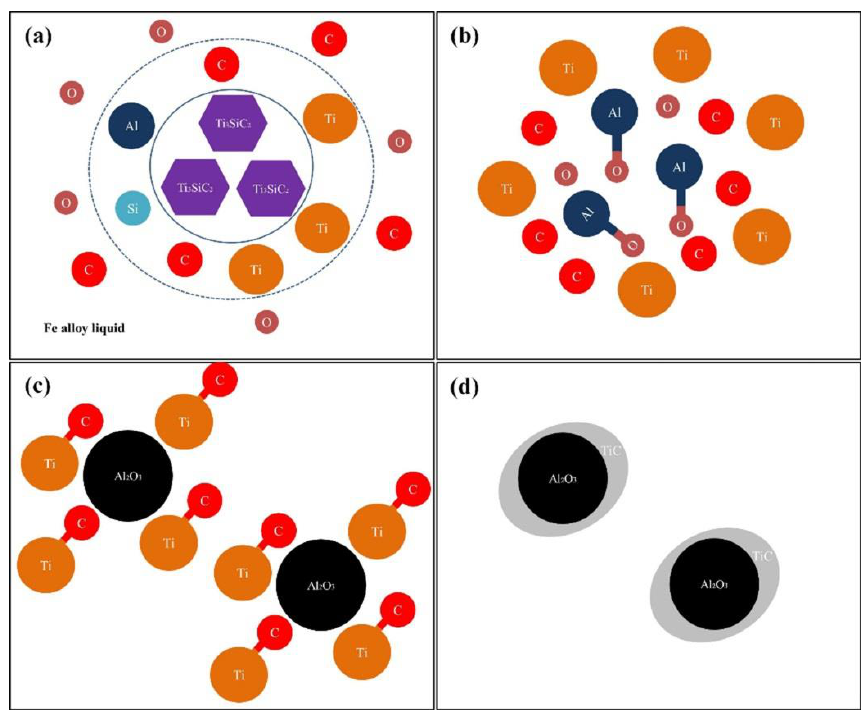
Figure 11. Schematic diagrams of nucleation and growth behaviors of Al 2 O 3 /TiC composite ceramics: ( a ) dissolution of Ti 3 SiC 2 ; ( b ) the bonding of Al-O; ( c ) the formation of Al 2 O 3 ; ( d ) the formation of Al 2 O 3 /TiC composite ceramics Coatings 2020 , 10 , x FOR PEER REVIEW 10 of 16 Table 4. FWHM values of the three primary peaks in coating 1 and coating 2 (2θ/°). Samples Peak І Peak П